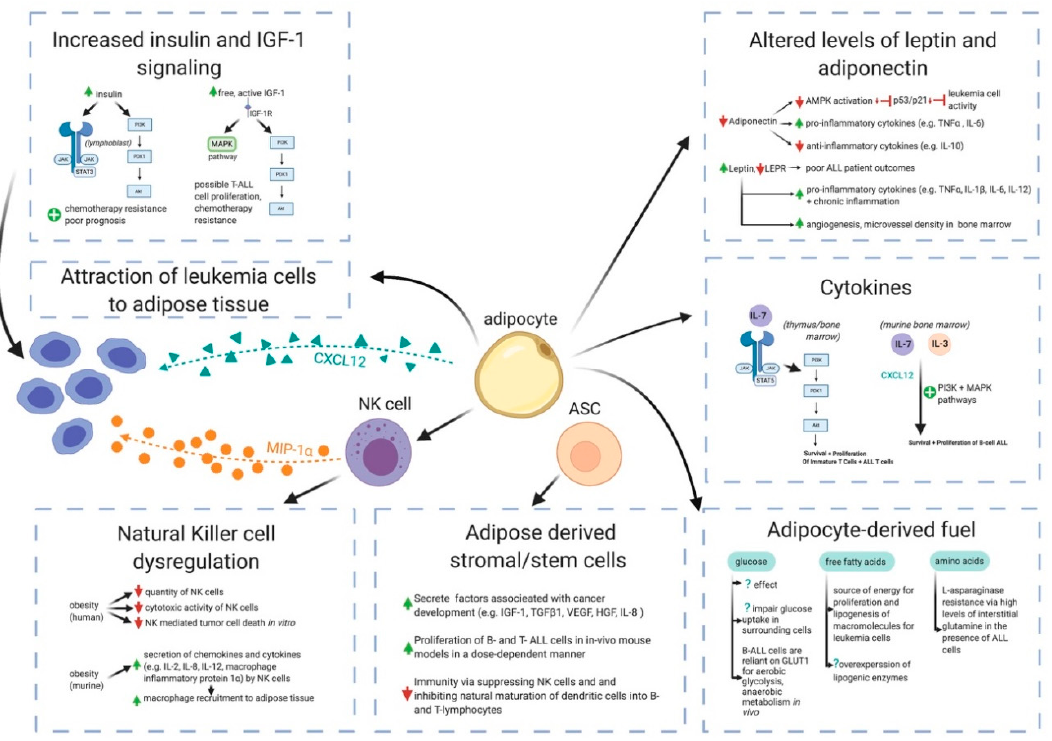
Figure 1. Potential mechanisms for obesity associations with ALL. The adipocytes secrete chemokines that can attract leukemia cells, including cysteine-X-cysteine (C-X-C) motif chemokine 12 (CXCL12). Adipose tissue-infiltrating Natural Killer (NK) cells secrete macrophage inflammatory protein-1 alpha (MIP-1 α ), another chemokine for leukemia cells. Obesity is also associated with reduced numbers and cytotoxic activity of NK cells. Adipose-derived stromal / stem cells (ASC) secrete factors that promote the proliferation of lymphoblasts.